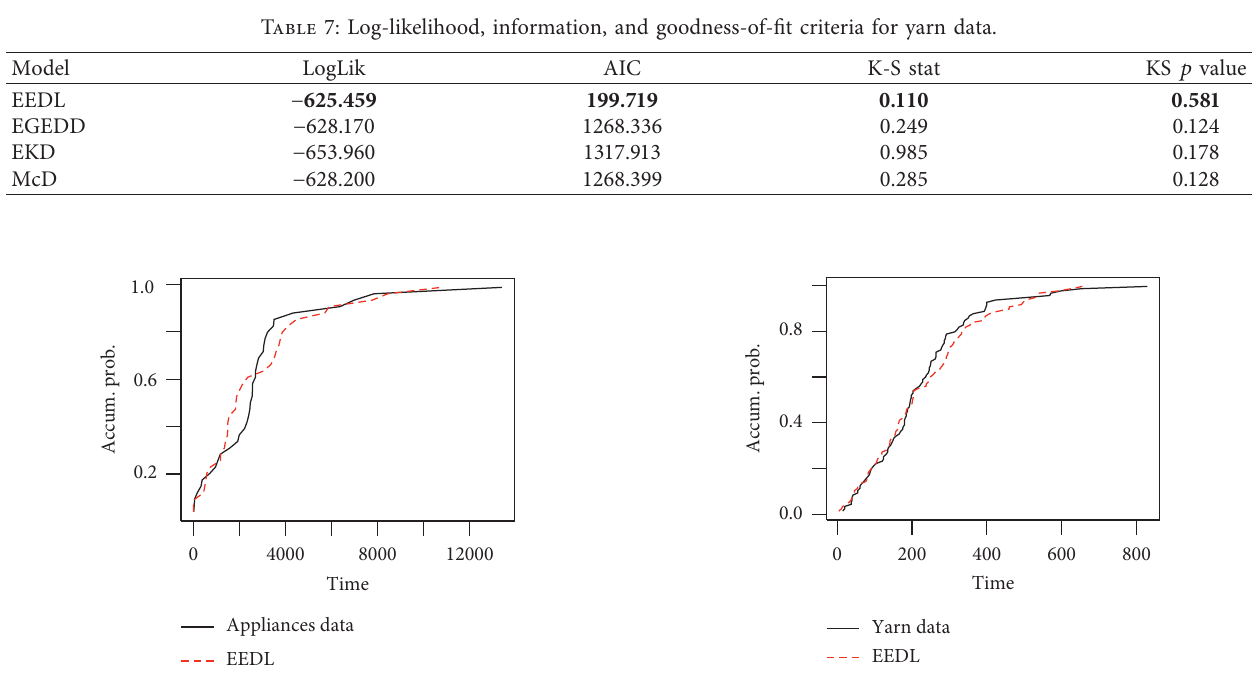
Figure 6: TTT plot of appliances. Figure 7: TTT plot of